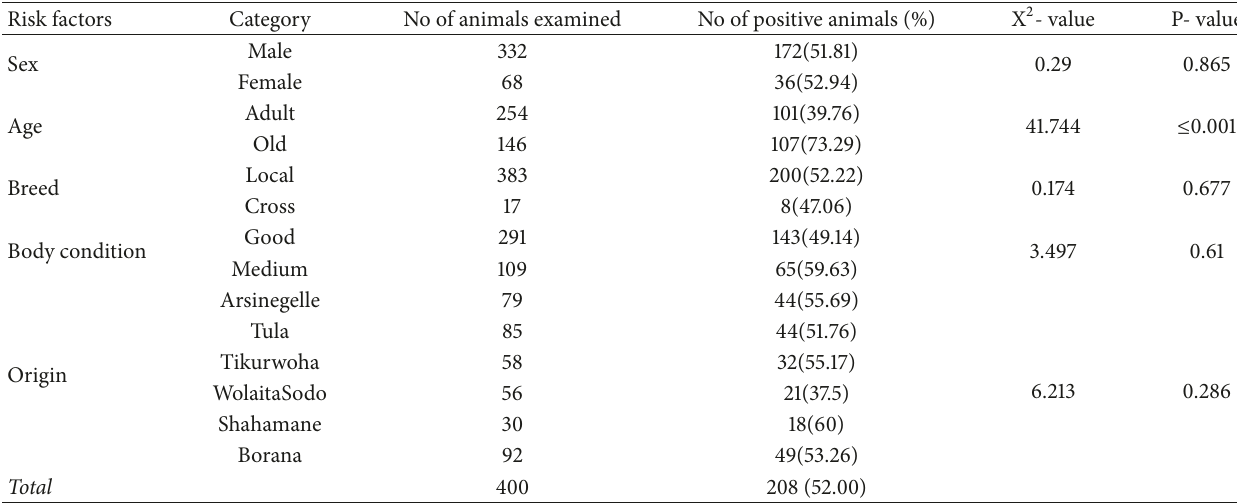
Table 4: Chi-square analysis of risk factors with prevalence of